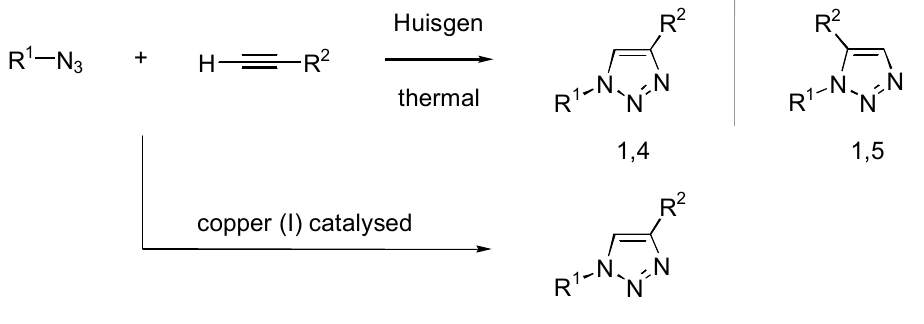
Figure 1 . Huisgen’s cycloaddition route to 1,2,3-triazoles and its copper (I) catalyzed